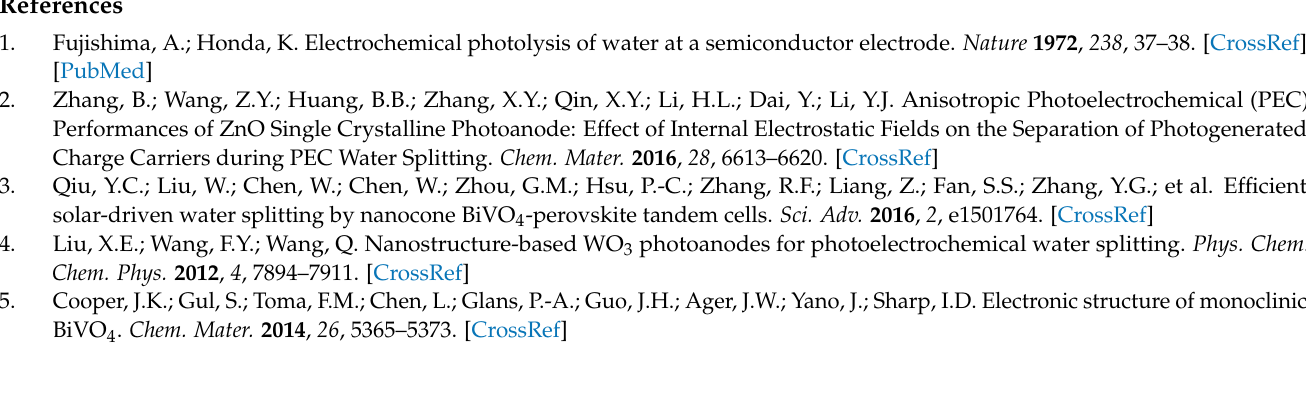
(C) and Mo-BVO (C), Figure S2: Top-view and cross-sectional SEM images of BVO and Mo-BVO films on FTO substrates, Figure S3: XRD patterns of BVO (C), Mo-BVO (C), BVO and Mo-BVO films on FTO substrates, Figure S4: UV-Vis absorption spectrums of Mo-BVO(C) powder and BVO(C) powder from the Mo-BVO(C) ceramiac and BVO(C) ceramiac ground with a mortar, Figure S5: Photocurrent density versus applied potential (J-V) curves and Photocurrent vs. time (I-T) measured for the BVO(C) and BiVO 4 film photoanodes with a scan rate of 20 mV/s under AM 1.5G illumination in 0.1 M KPi buffer solution, Figure S6: Nyquist plots of Mo-BVO(C) and Mo-BVO samples, Figure S7: J-V and I-T curves measured for the Mo-BVO and Mo-BVO(C) photoanodes in 0.1M Na 2 SO 3 KPi solution, Figure S8: IPCEs for Mo-BVO and Mo-BVO(C) measured in the wavelength range from 350 to 550 nm at applied voltage of 1.23 V vs. RHE, Figure S9: XPS patterns of the Mo-BVO(C) electrodes in KPi before and after PEC stability tests, Figure S10: XPS patterns of the Mo-BVO electrodes in KPi before and after PEC stability tests, Table S1. EDS of Mo-BVO and Mo-BVO(C), Table S2: Mo content in Mo-BVO and